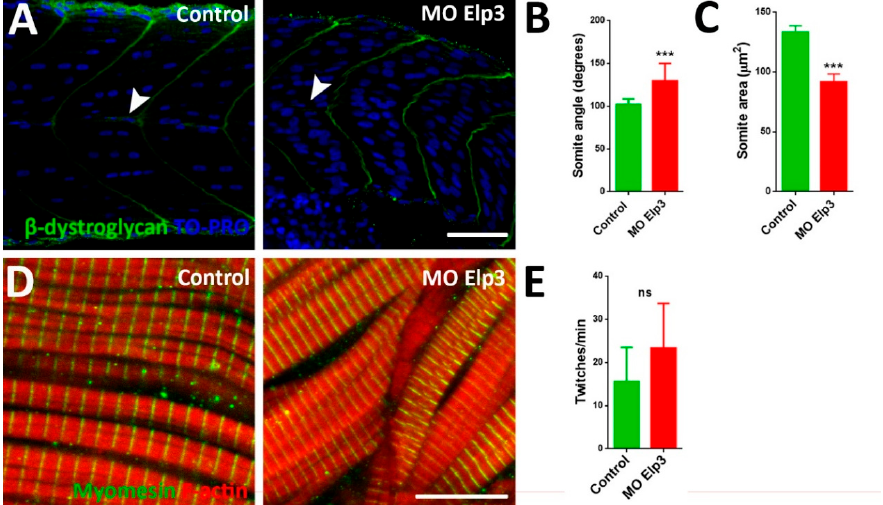
Figure 2. Aberrant somite shape and horizontal myoseptum in Elp3 morphants. To show somite boundary we detected β -dystroglycan in ( A ) control and morphant 48 hpf embryos, nuclei were stained with TO-PRO. Images representative of three independent experiments. Horizontal myoseptum is indicated with a white arrowhead. Scale Bar 50 µ m. Also, somite angle ( B ) and area ( C ) were measured ( N = 3, n = 50, t-Student. *** p < 0.005). Myomesin was also detected ( D ) in 48 hpf control and morphant embryos ( N = 3, n = 50, t-Student). Scale bar 10 µ m. ( E ) To evaluate muscle function coiling was measured counting twitches per minute in 30 hpf embryos ( N = 3, n = 50, t-Student; ns